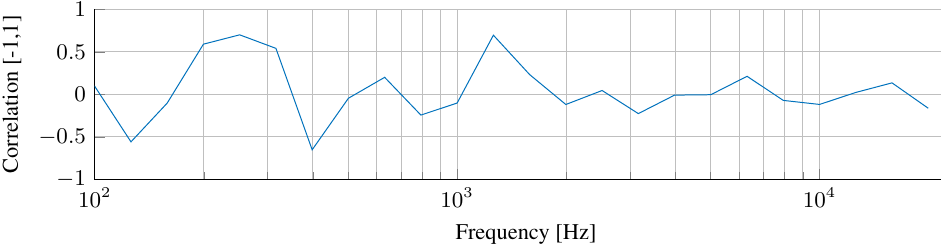
Figure 8. Decorrelator based on the proposed frequency-dependent Schroeder